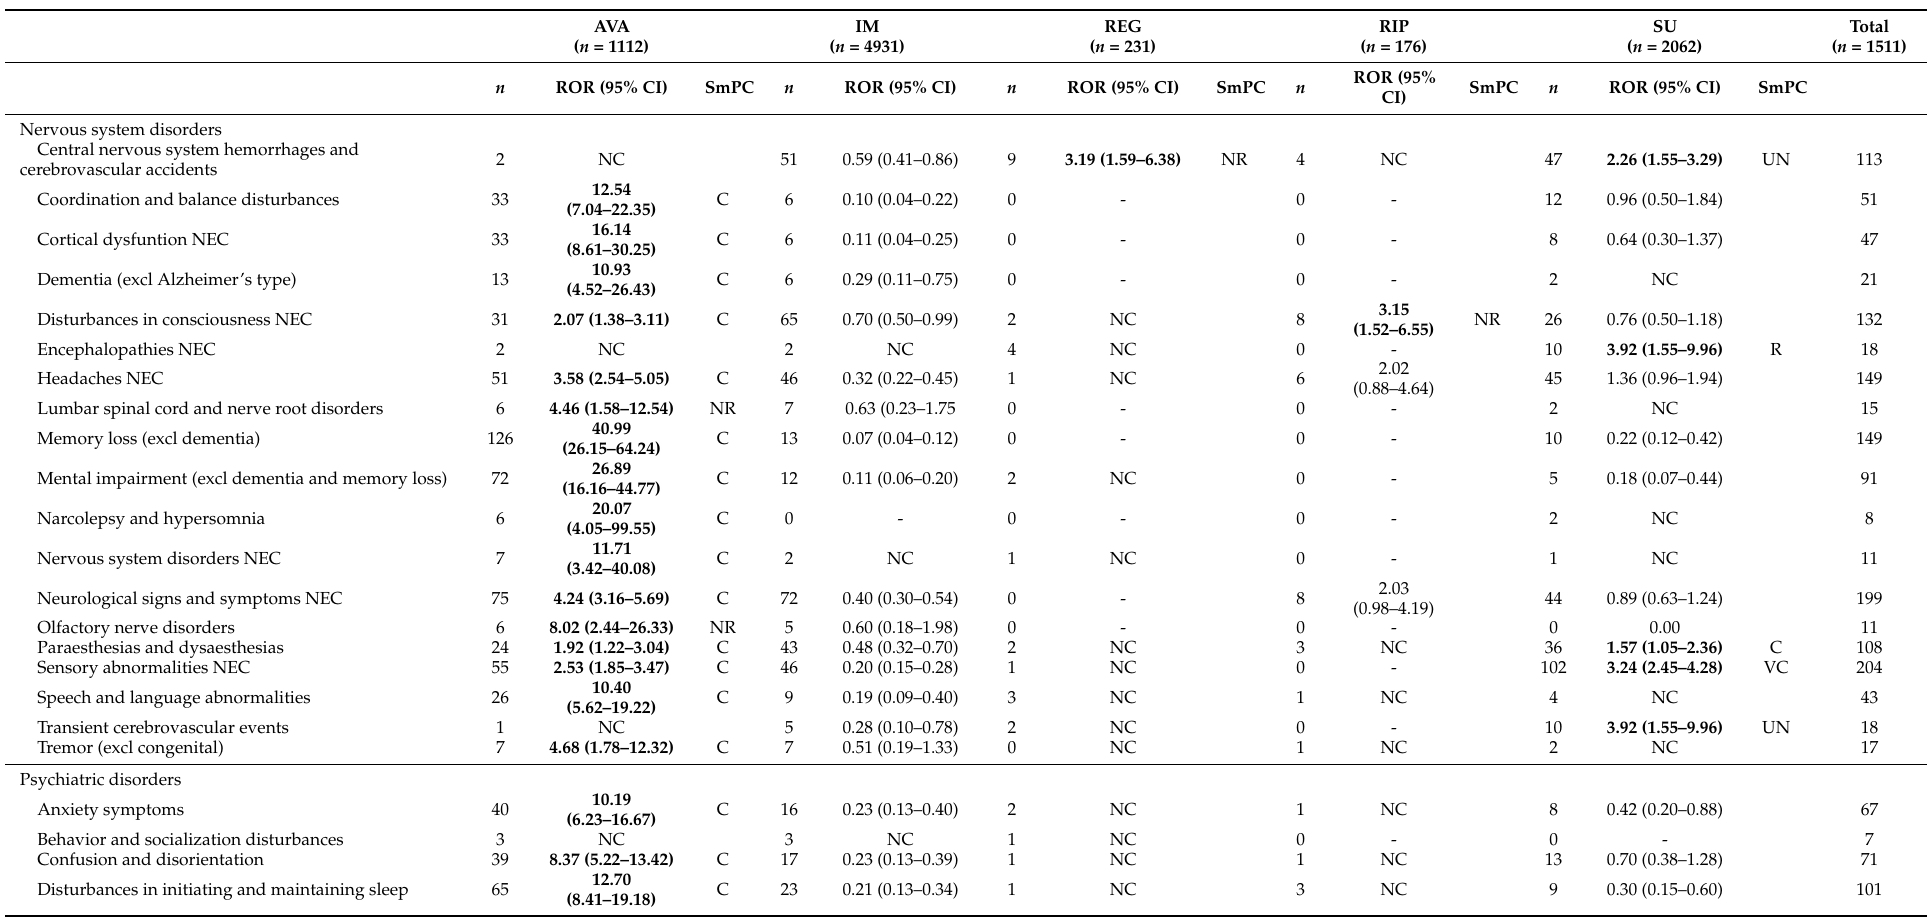
Table 4. ROR of ICSRs with ADRs belonging to the SOC “Nervous system disorders” or “Psychiatric disorders” by High Level Term for the comparison of